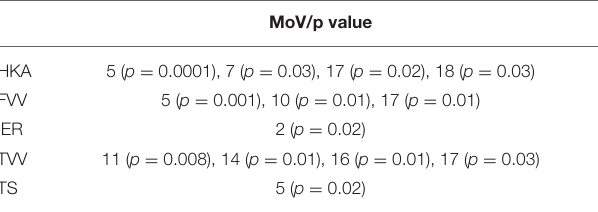
TABLE 6 | SSM parameters that were statistically significant for the logistic regression.